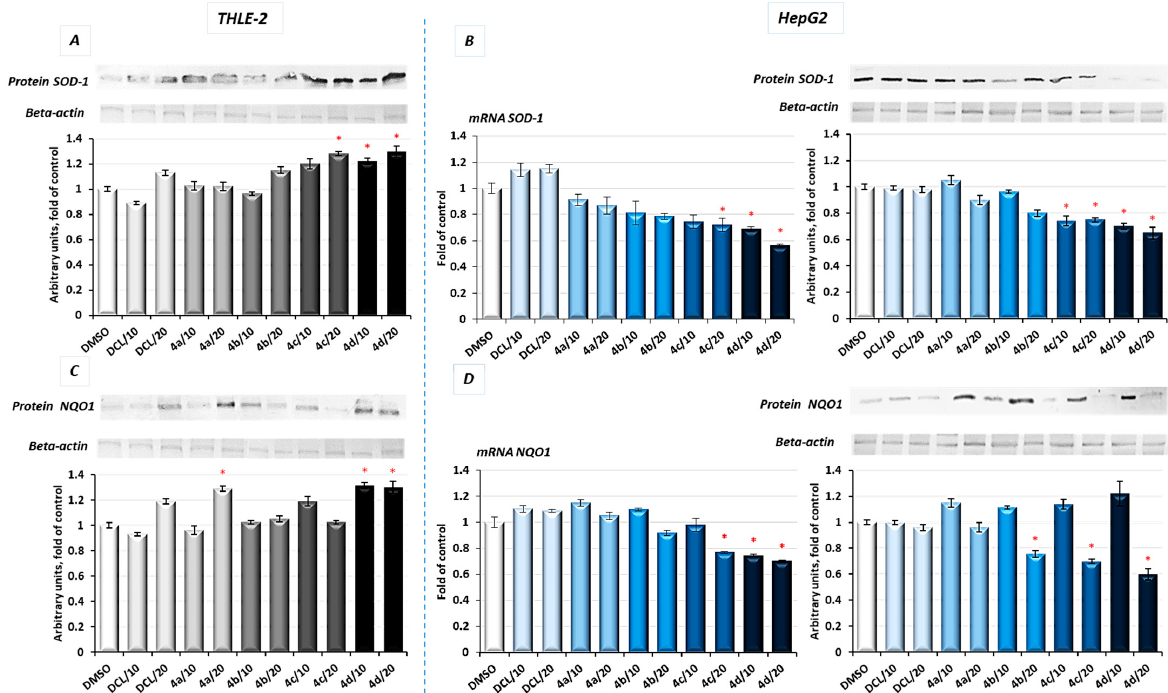
Figure 4. The effect of the DCL and DCL–OAO derivative conjugates ( 4a – 4d in 10 and 20 μ M concentrations) on SOD ‐ 1, ( A , B ) and NQO1, ( C , D ) mRNA and protein levels in THLE ‐ 2 and HepG2 cells after 24 h incubation. The values (mean ± SEM) for the mRNA ( B , D ) levels were calculated from three separate experiments in comparison to control cells set to 100%. Representative immunoblots of the cytosolic content of SOD ‐ 1 and NQO1 in THLE ‐ 2 ( A , C ) and HepG2 cells ( B , D ) from three separate experiments are shown. The sequence of the bands corresponds to the sequence of the bars in the graph. β‐ actin was used as a loading control. The values were calculated as protein levels in comparison to control cells set to 100%. * Significantly different from control—DMSO ‐ treated cells, p < 0.05. Statistical significance was assessed by Student’s ‐ t ‐ test.